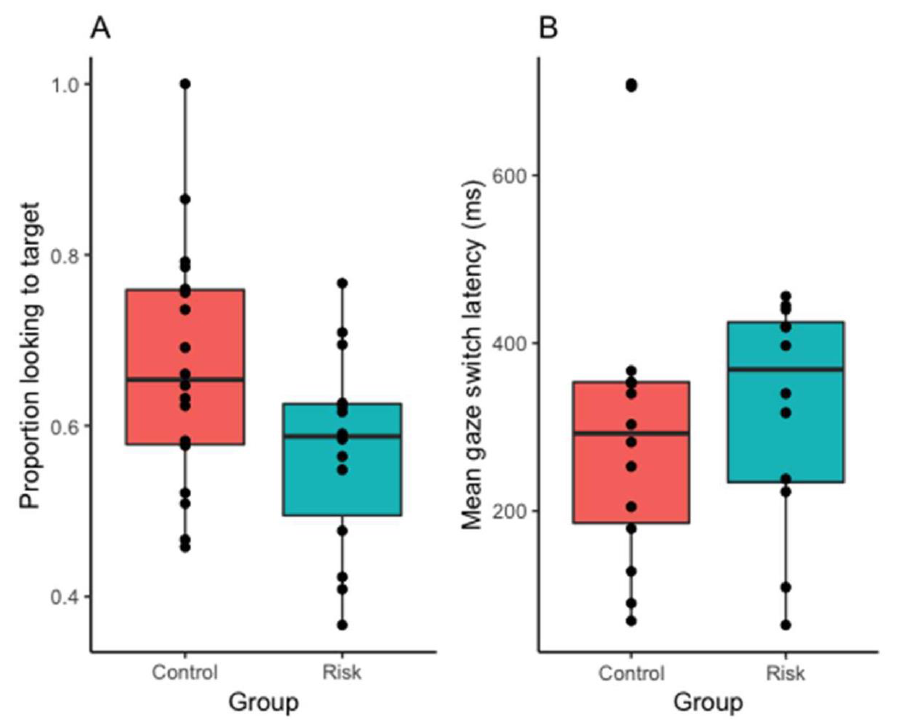
Figure 3. Mean accuracy ( A ) and latency ( B ) of infants’ lexical processing performance (black dots represent individual scores and the internal line represents the median, and the hinges extend to the first and third